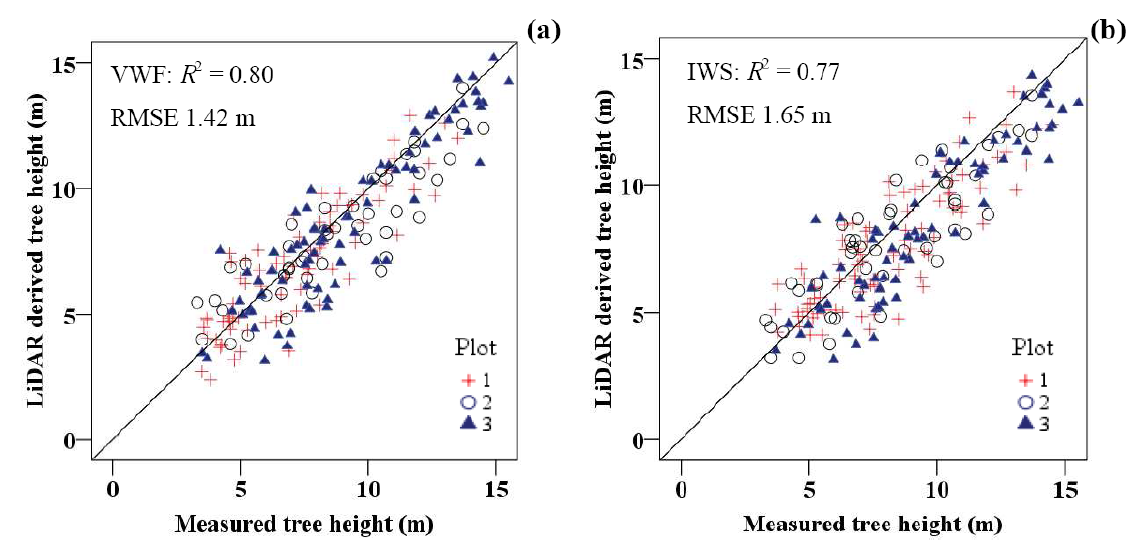
Figure 7. Tree height measured versus LiDAR-derived tree height ( a ) and ( b ) using the VWF and IWS methods,